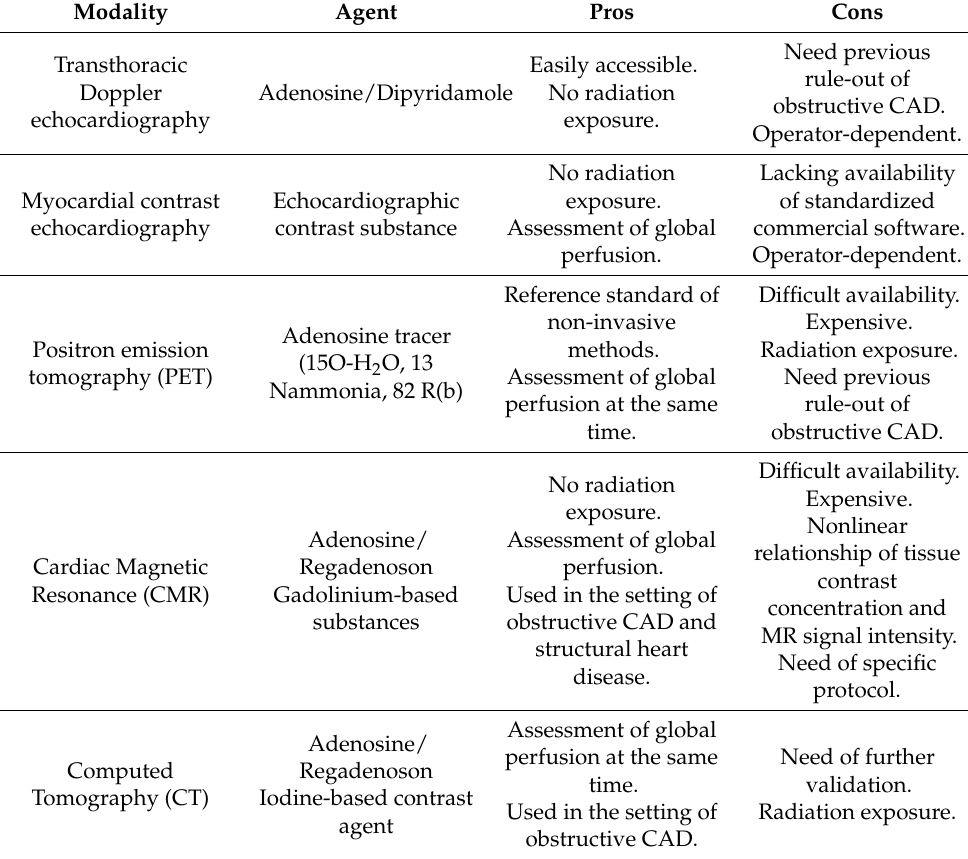
Table 1. Characteristics of non-invasive methods for coronary microvascular dysfunction